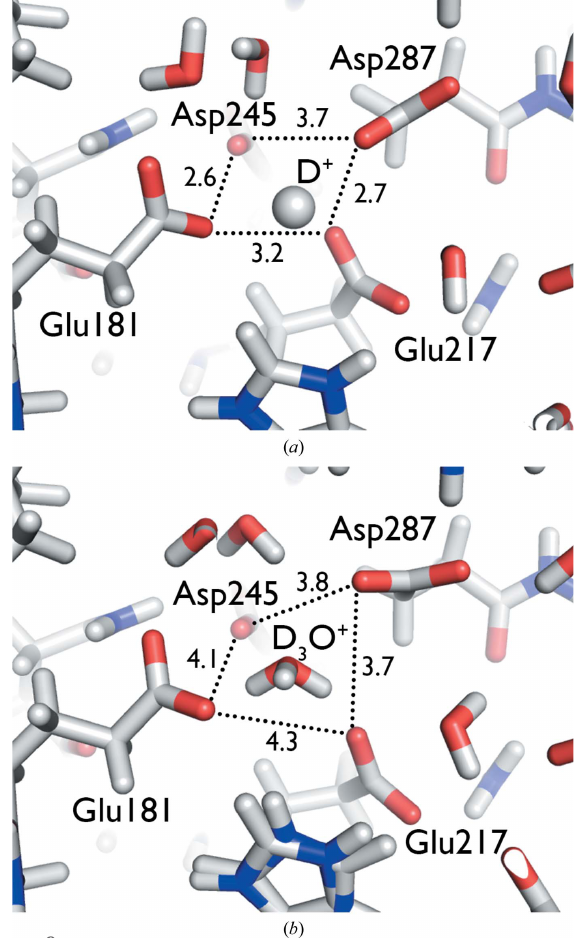
Figure 9 ( a ) Interaction of metal-coordinating residues in XI with D + at pH 5.9 (PDB entry 3qza). ( b ) Interaction of metal-coordinating residues in XI with D